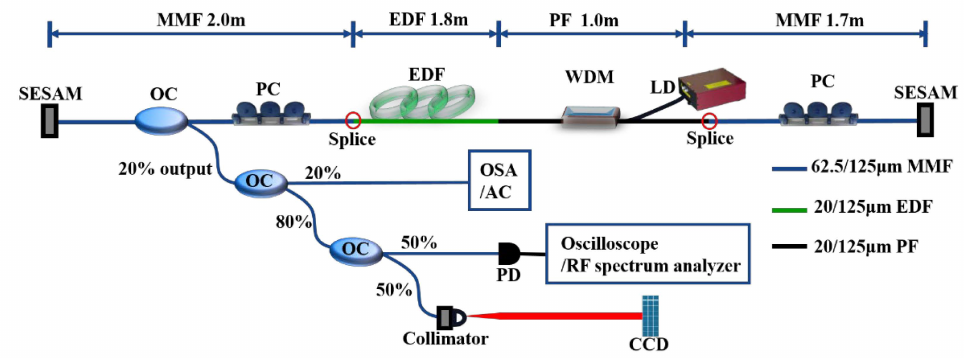
Figure 1. Schematic of the multi-wavelength STML fiber laser and the measurement